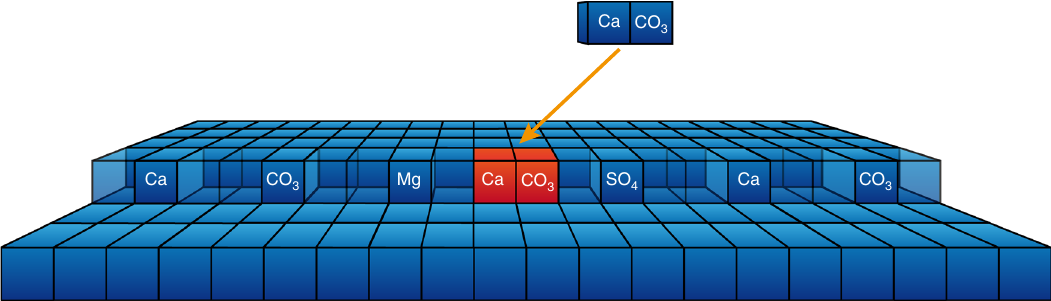
Fig. 1 The growth inhibition model. A generic step edge consisting of empty sites (transparent) and the sites occupied by various ions present in the solution. On calcite, kinks are formed by the attachment of a calcium carbonate ion pair (in red), which is assumed to be the rate determining reaction in the growth process. Adsorbed single ions block the sites for growth